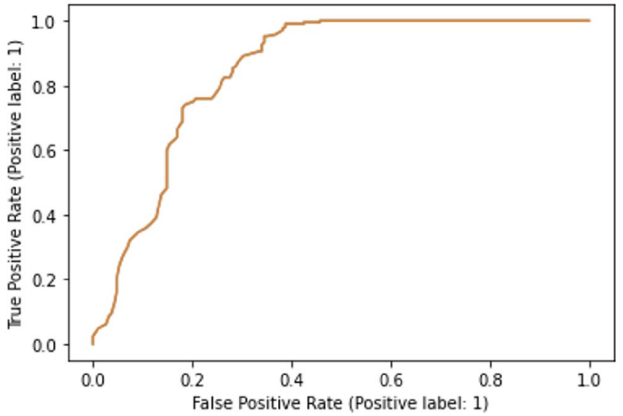
Figure 6. Receiver operating characteristics curve for the random forests model.